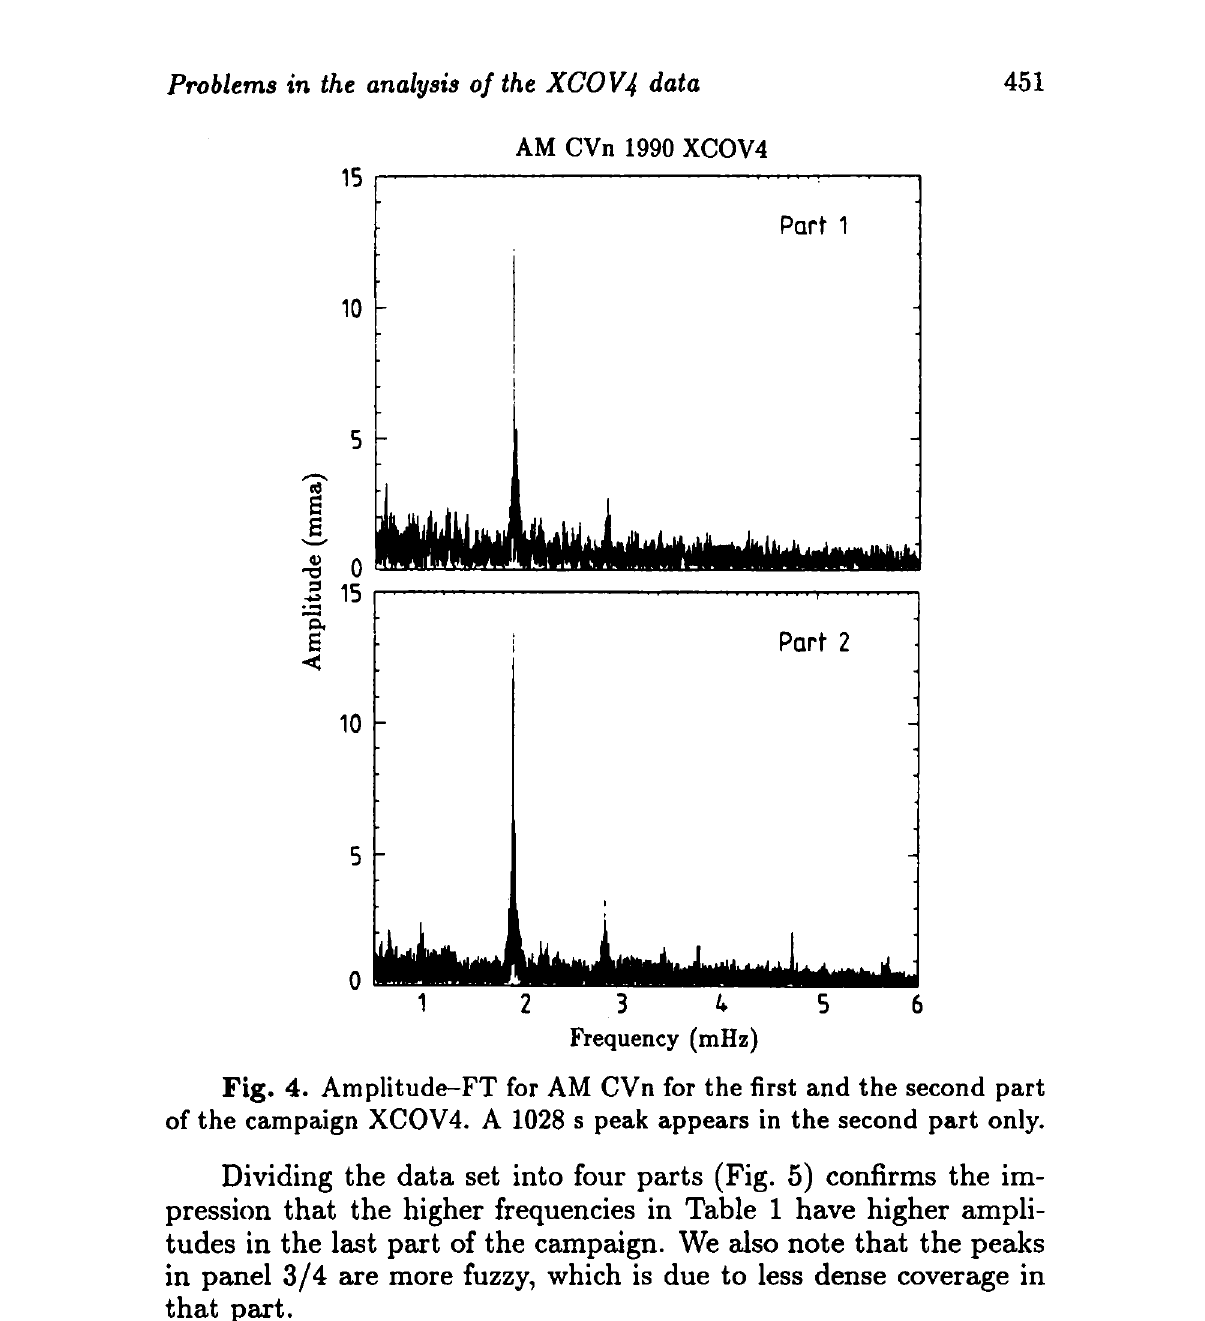
Fig. 4. Amplitude-FT for AM CVn for the first and the second part of the campaign XCOV4. A 1028 s peak appears in the second part